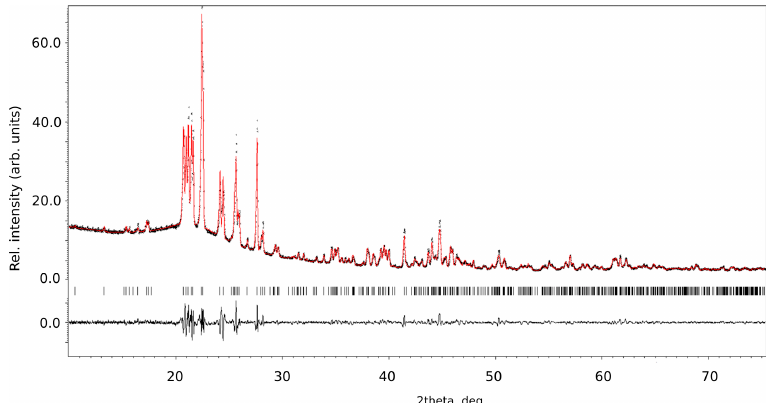
Figure 1. Powder X-ray diffraction pattern (at 293 K) of Ba(OsF 6 ) 2 : the experimental data (black crosses), the Rietveld profile (red), and the differential profile (bottom, black). The calculated reflection positions for Ba(OsF 6 ) 2 are shown as black ticks. R p = 0.0343, wR p = 0.0492.